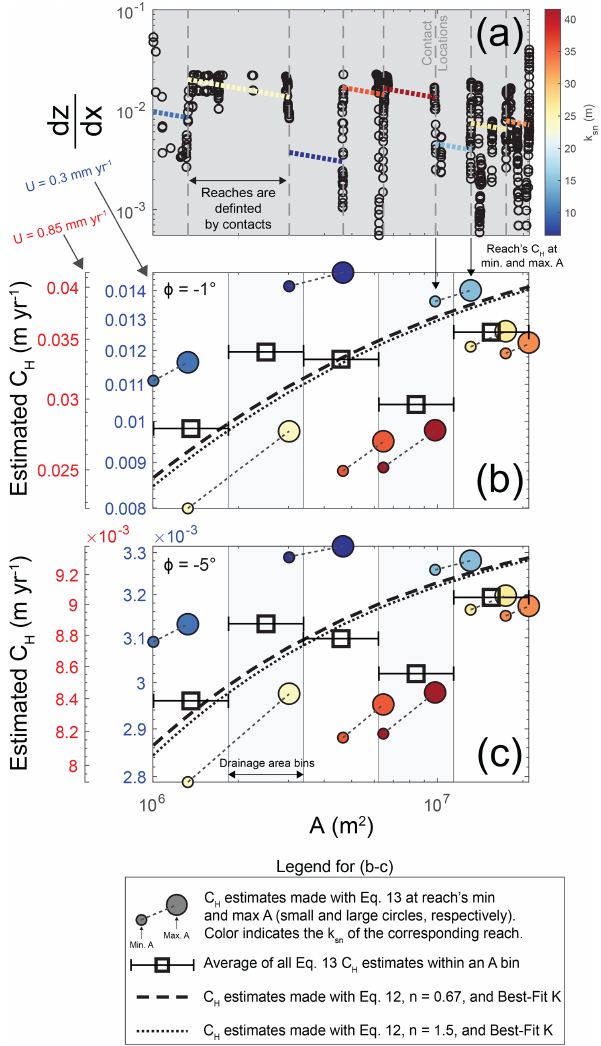
Figure 15. Preliminary analysis for Tank Wash. (a) Slope–area plot with gray dashed lines for each presumptive contact identified in Fig. 14. The average steepness ( k sn ) of each reach between con- tacts is shown as colored dotted lines. (b, c) Kinematic wave speed values ( C H ) estimated with Eq. (13) using the average k sn values, rock-uplift rate U = 0 . 3mmyr − 1 or U = 0 . 85mmyr − 1 (separate axes), and contact dip ( φ ) values of either (b) − 1 ◦ or (c) − 5 ◦ . See Fig. 16 for the best-fit K values.